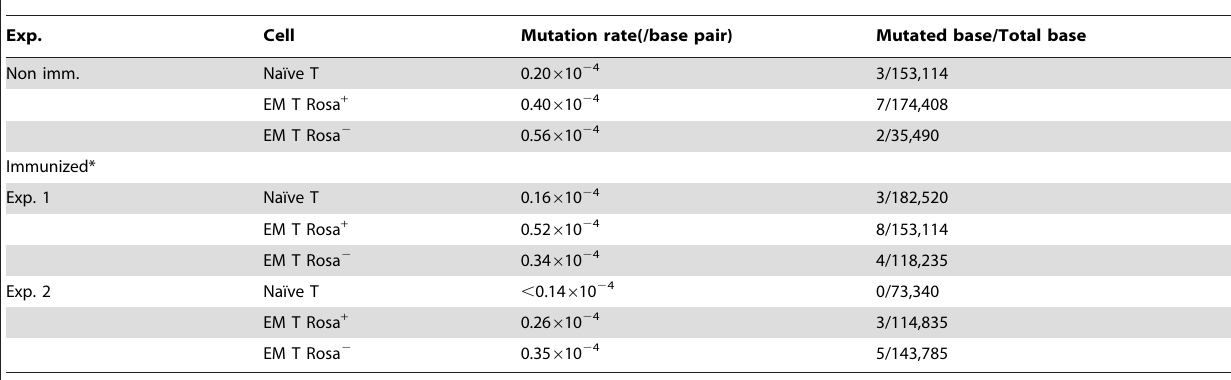
Table 2. Mutation frequency of Myc exon 1-intron 1 region.